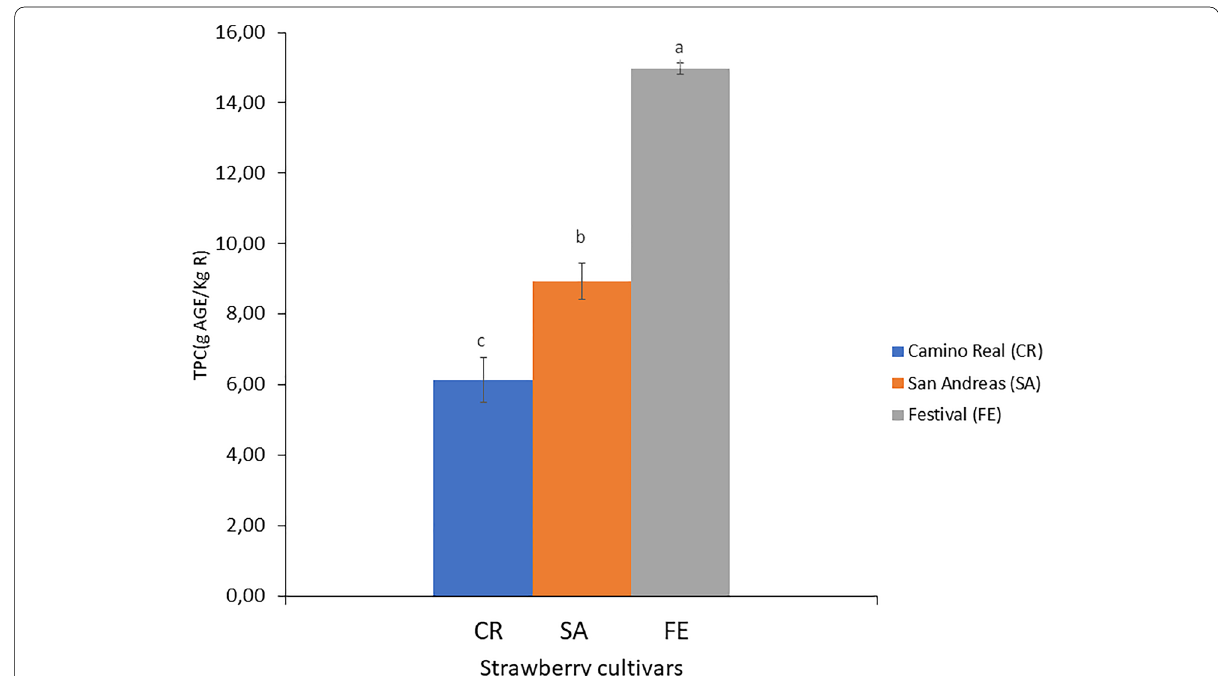
Fig. 1 Total phenolic content (TPC) in the by‑products of three strawberry cultivars. Different letters indicate significant differences ( p < 0.05) among cultivars by Tukey’s